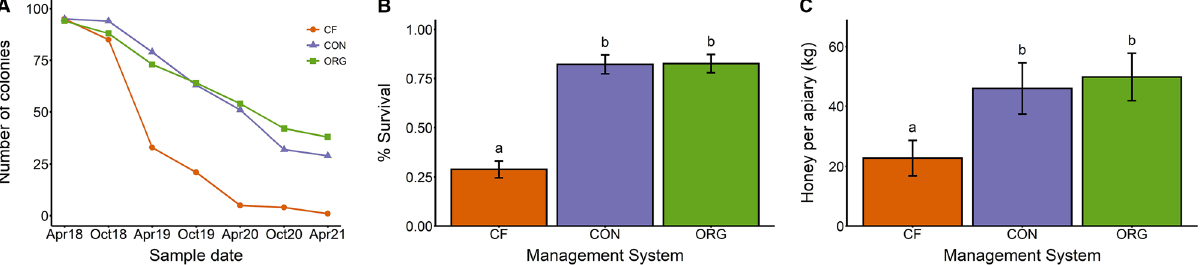
Figure 3. Summary of the effects of management system on the ( A ) number of colonies, ( B ) overwintering survival, and ( C ) honey production per apiary over the three years of the experiment. The three tested management systems were chemical-free (CF, orange), conventional (CON, blue), and organic (ORG, green). Columns with different letters are significantly different from each other (Tukey HSD p -value < 0.05). The number of colonies after April 2020 does not include colonies from apiaries in West Virginia.